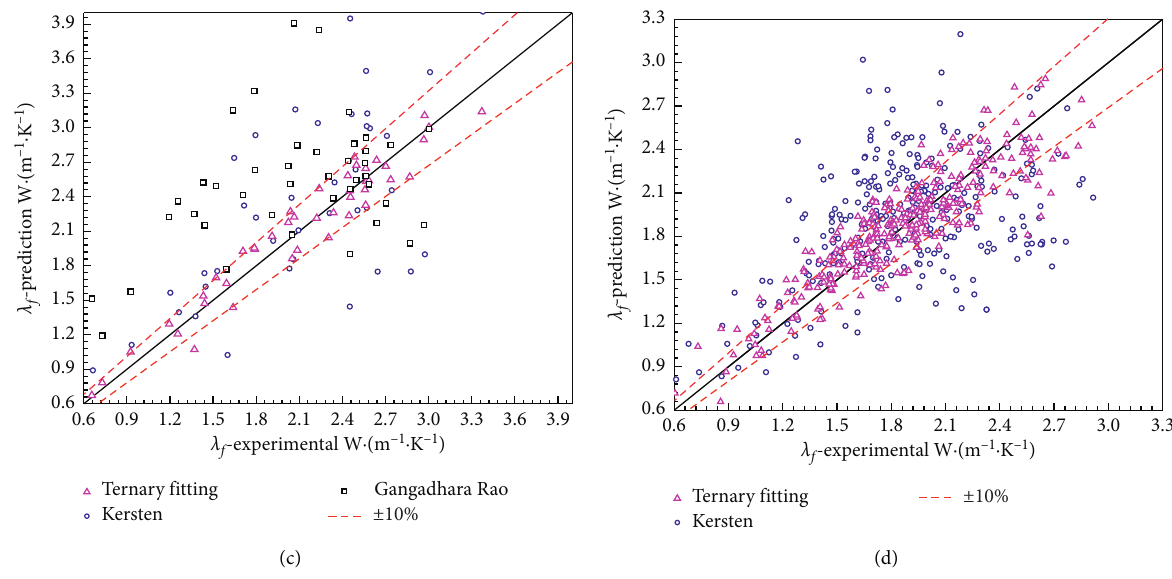
Figure 5: A comparison of measured and estimated frozen soil thermal conductivity. (a) Slit. (b) Fine sand. (c) Gravel sand. (d) Fine-grained sand.